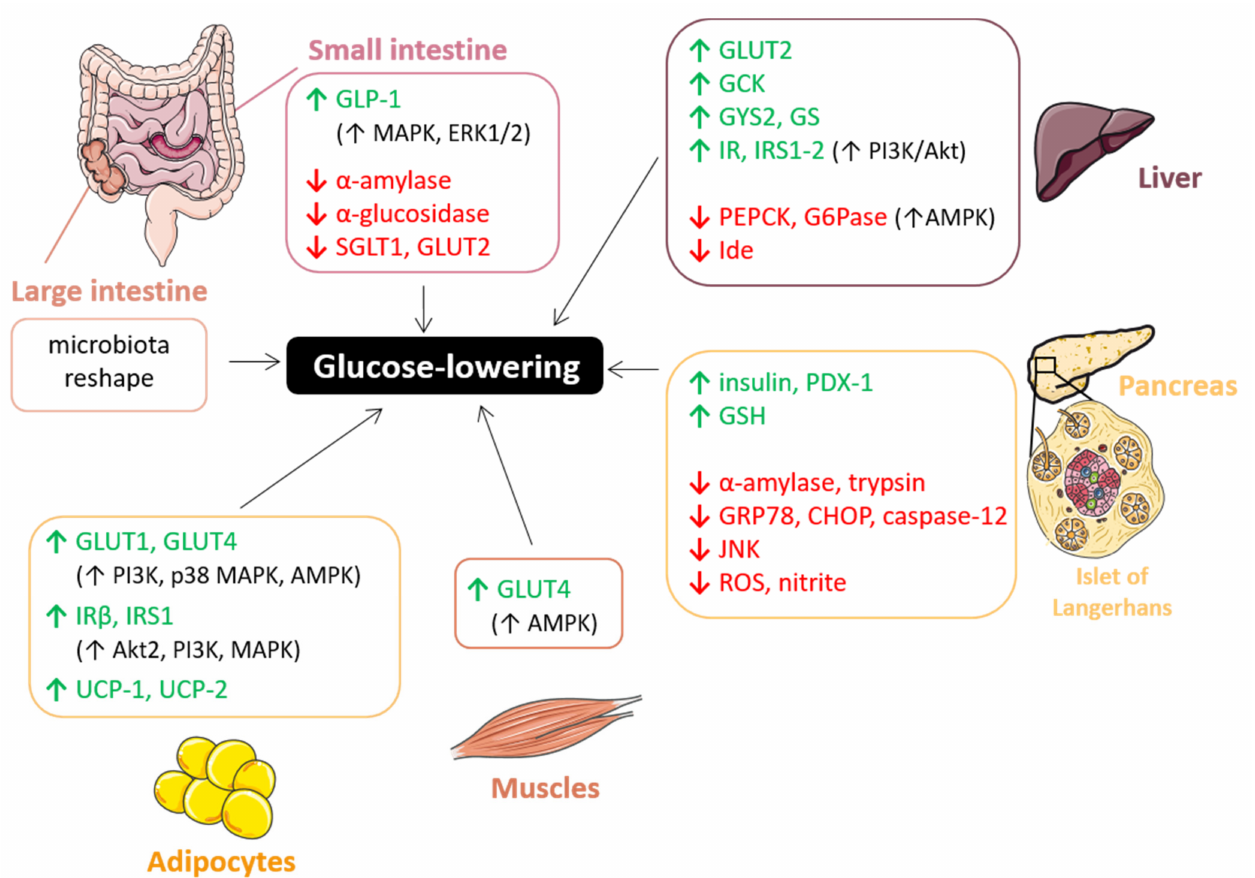
Figure 15. Schematic representation of the molecular mechanisms through which PACs affect glucose metabolism pro- tecting against hyperglycemia. ↑ increase; ↓ decrease. The figure was created using Servier Medical Art by Servier (smart.servier.com, accessed on 12 March 2021), licensed under a Creative Commons Attribution 3.0 Unported